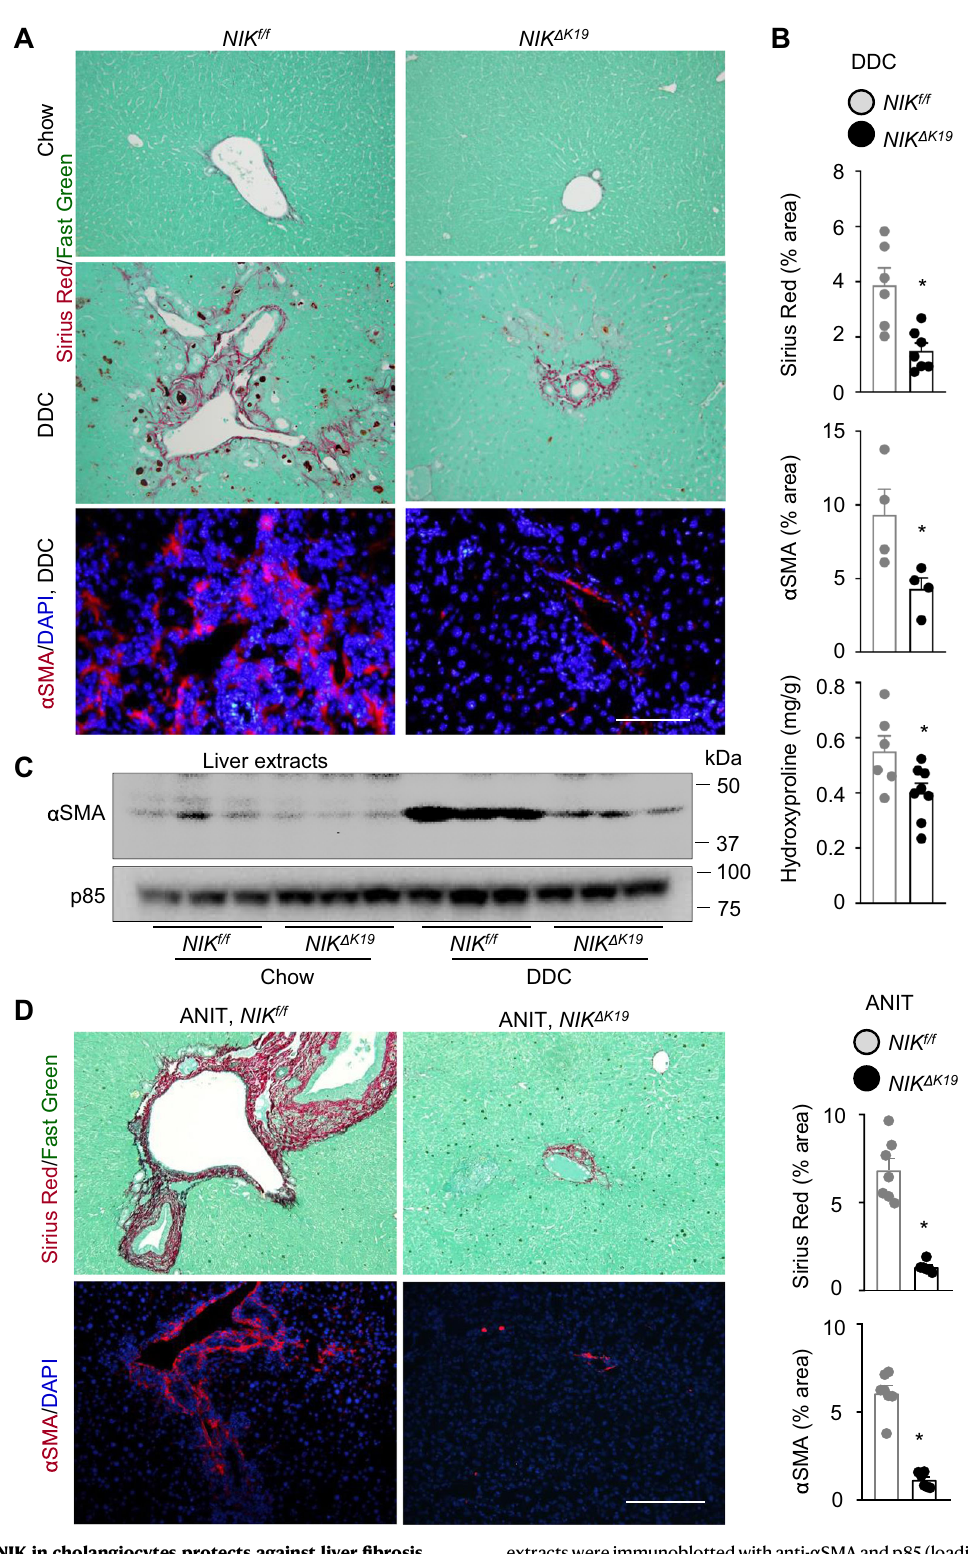
extractswereimmunoblottedwithanti- α SMAandp85(loadingcontrol)antibodies. Each lane represents one individual animal ( n =3 mice per group). D NIK Δ K19 ( n =6 mice) and NIK f/f ( n =7 mice) male mice were fed an ANIT diet for 3weeks. Liver sections were stained with Sirius red/fast green or anti- α SMA. Scale bar: 200 μ m. Sirius red and α SMA areas were normalized to total areas. Data are presented as mean±SEM. * p <0.05, 2-tailed student ’ s t -test. Source data are provided as a Source Data fi